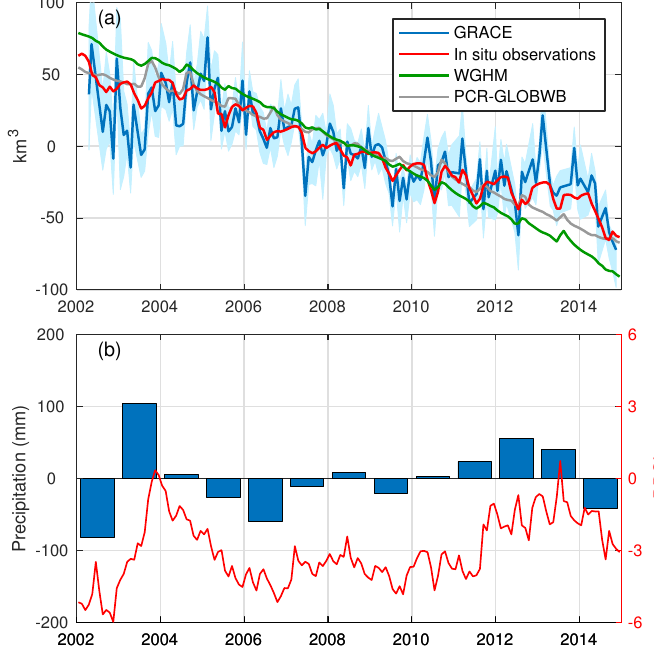
Figure 5. ( a ) Time series of GWS changes in the NCP from GRACE, in situ observations, WGHM and PCR-GLOBWB from 2002 to 2014. Shaded areas are estimated uncertainties in GRACE-derived GWS changes. ( b ) Annual precipitation anomalies and PDSI values in the NCP from 2002 to